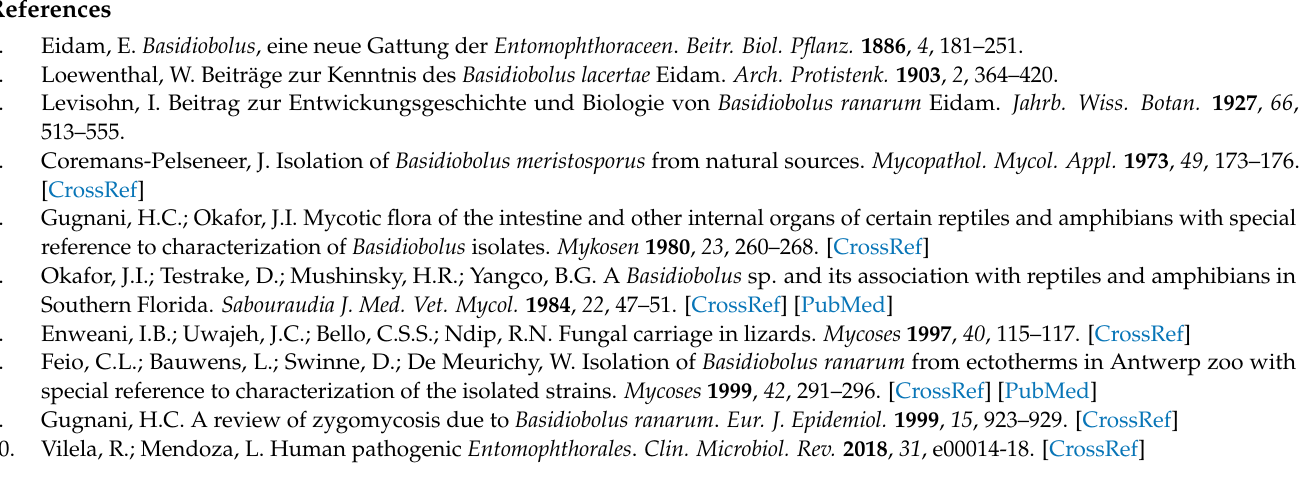
Table S1: Statistical analysis of the lockdown effect on Basidiobolus spp. counts in gecko droppings collected in different seasons; Table S2: Statistical comparison of Basidiobolus spp. counts of in- door and outdoor samples from the matching seasons; Table S3: Monthly average temperatures for Pietermaritzburg